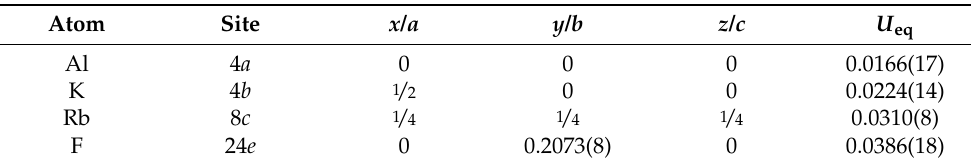
Table 6. Fractional atomic coordinates and equivalent isotropic displacement parameters (in 10 4 pm 2 ) of Rb 2 KAlF 6 .